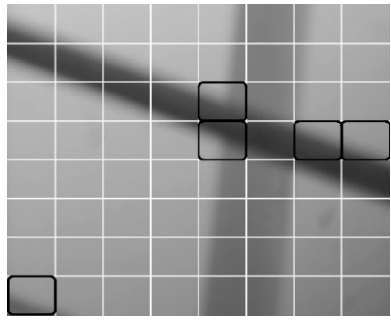
Figure 5. Dynamic focus window for the scene in Figure 3h.